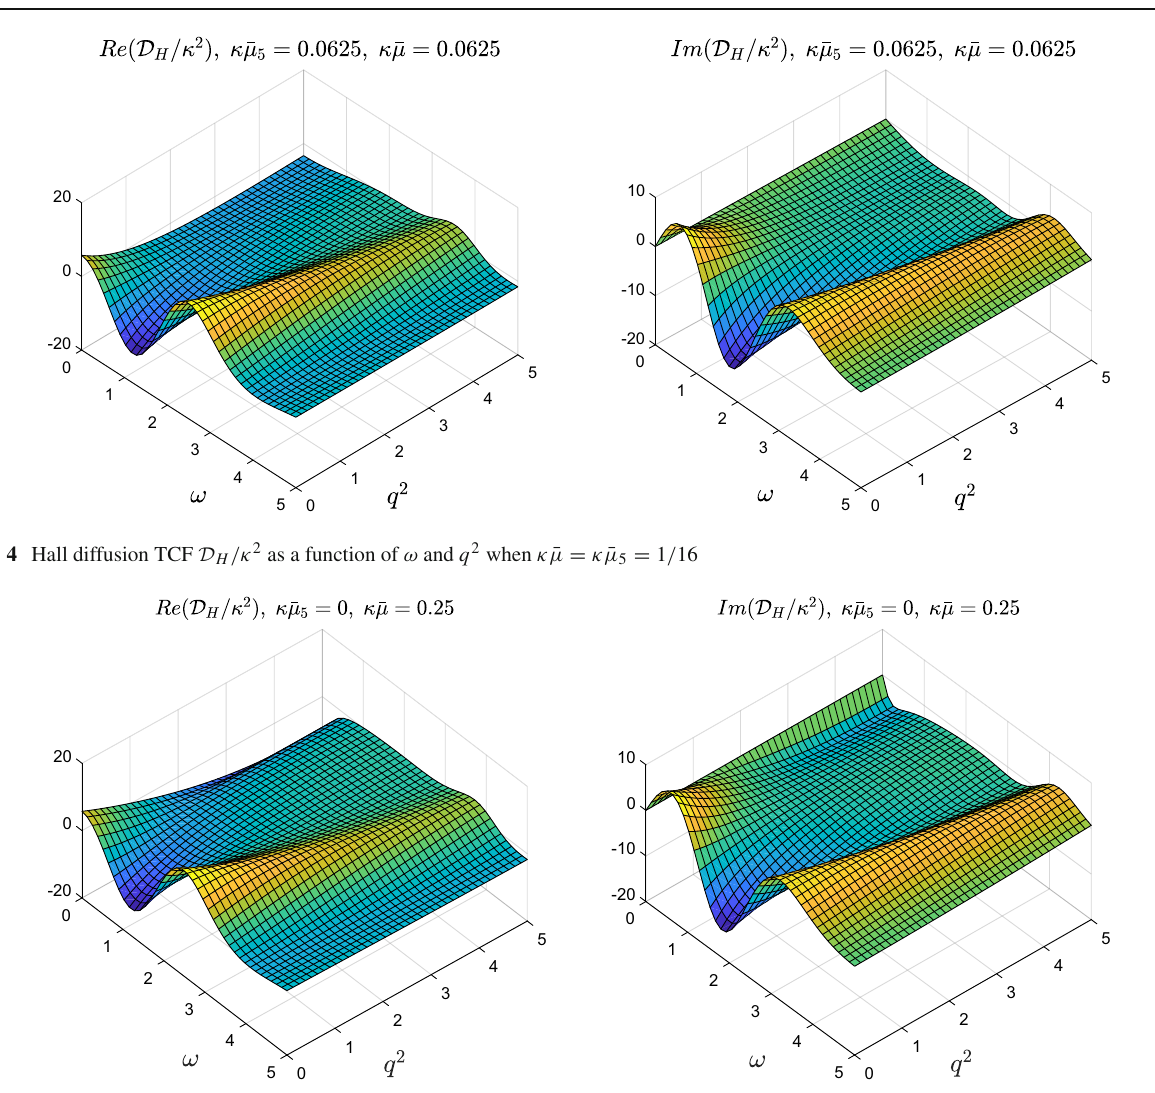
Fig. 5 Hall diffusion TCF D H /κ 2 as a function of ω and q 2 when κ ¯ μ = 1 / 4, κ ¯ μ 5 =